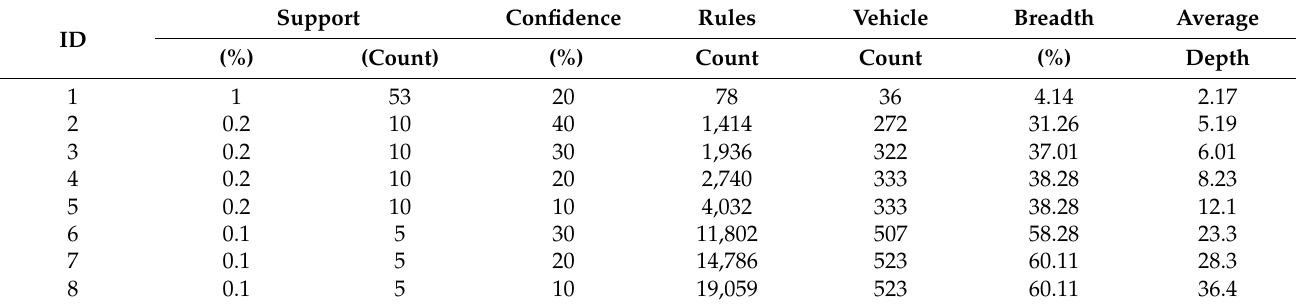
Table 3. Association rules with various